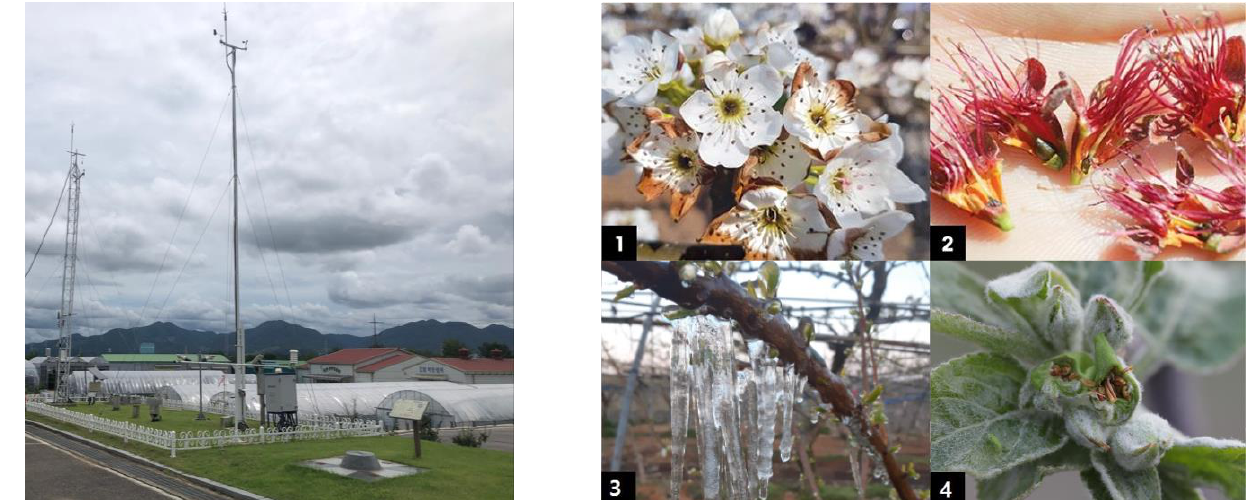
Figure 2. Left panel is two automatic weather stations of Korea Meteorological Administration ( right tower ) and Rural Development Administration ( left tower ) at the study area shown in Figure 1c. Right panels show crop damages due to sudden low temperature or frost (1: The petals of pear blossoms and the top of the ovary turned black; 2: Peach flowers that turned dark red; 3: The icicles on the pear tree and the frozen spray water; 4: The apple, which is in the state of a bud, turned yellow in the temperature that fell below zero (Source: © Nongmin News Corp. with photographs by Gyo-Hyun Chu).